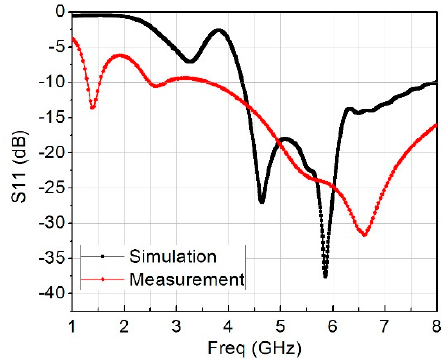
Figure 7. Measured and simulated S11.